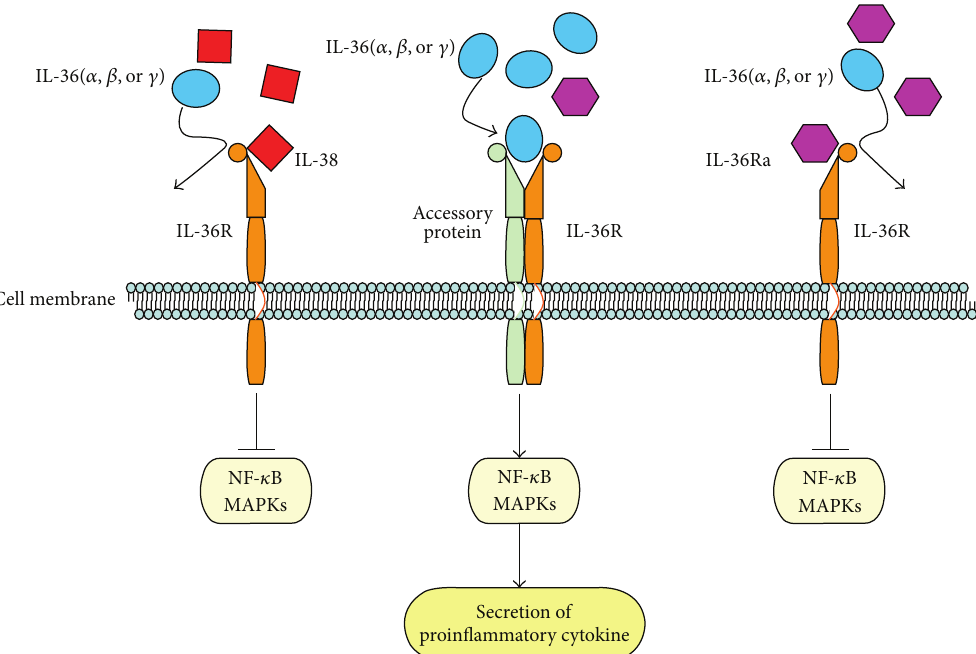
Figure 2: Receptor and signaling pathway of